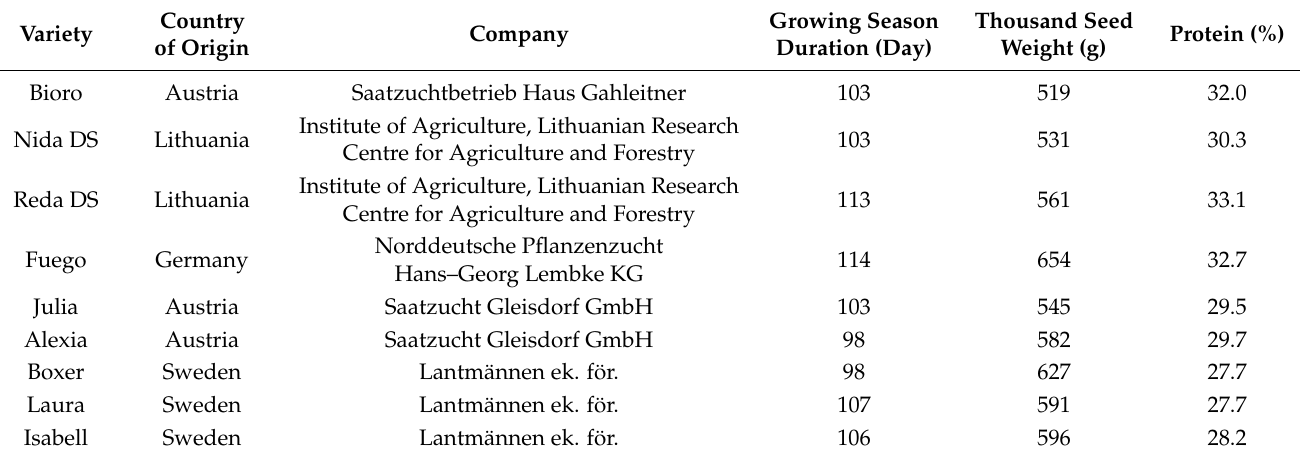
Figure 1. Experiment site location. Table 1. The country of origin of the tested faba bean